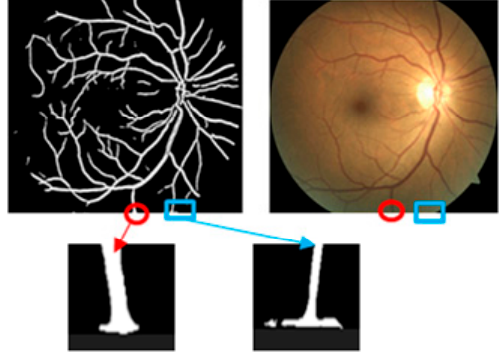
Figure 4. Edge misdetection after split FOV.